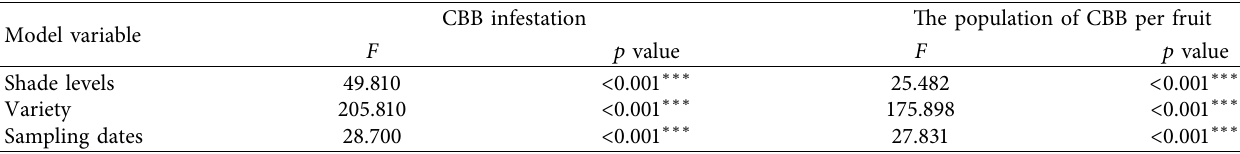
Table 2: Generalized linear mixed model (GLMM) estimates for infestation of the total number of individuals of cofee berry borer (CBB) fruit according to shade levels, cofee varieties, and sampling